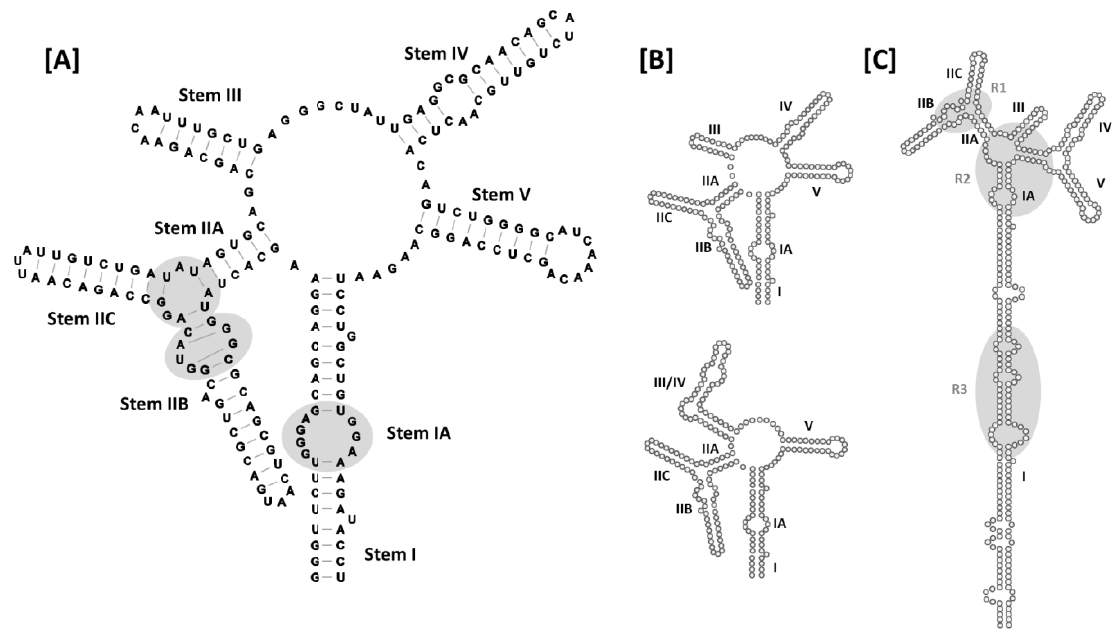
Figure 4. Secondary structures of HIV-1 RREs: ( A ) 5-stem structure. Sub-structure designations and base-pairing patterns, including non-canonical G-A and G-G base pairs in stem IIB, are indicated. Established Rev binding sites at IIB, the stem loop II junction and stem IA are also shown (gray ovals); ( B ) Comparison of the 5- and 4-stem structures. Differences between the two models are limited to the base pairing patterns of nucleotides comprising stem loops III and IV, and stem loop III/IV, in the respective structures. Due to space limitations, stem I has been truncated in the models presented in panels ( A – C ).